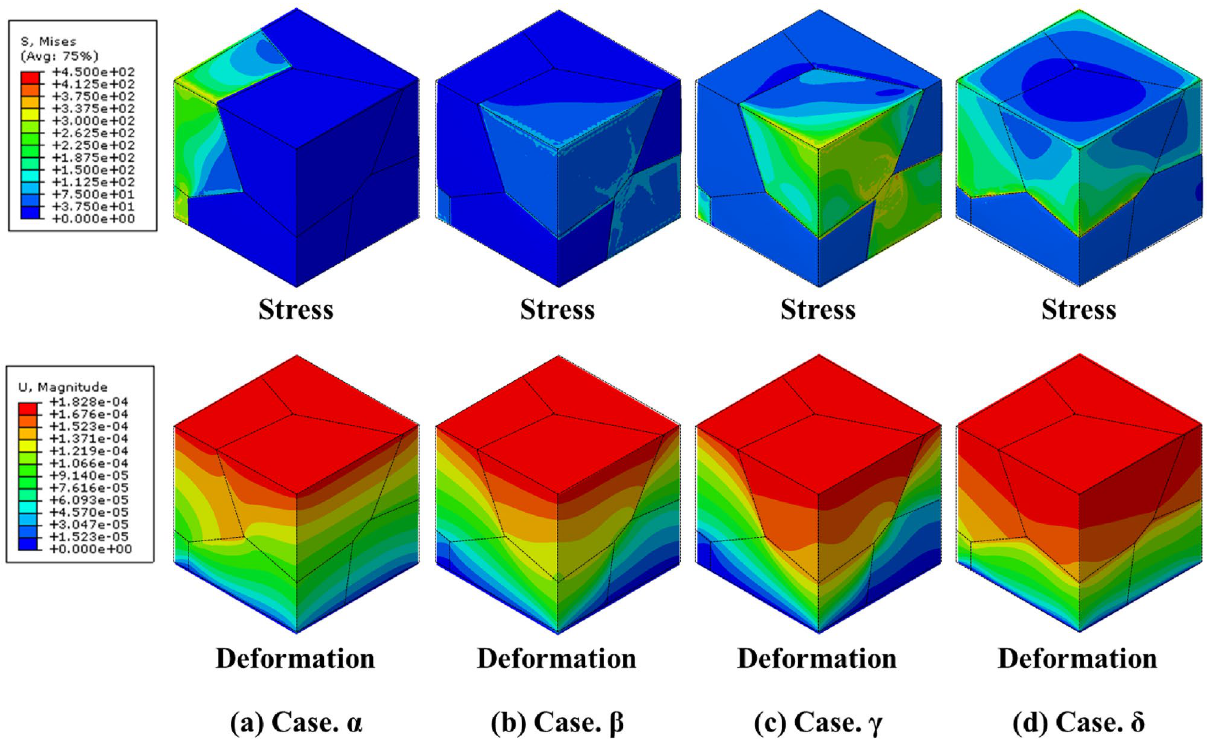
Figure 9. Stress and deformation FEM results of group 3.